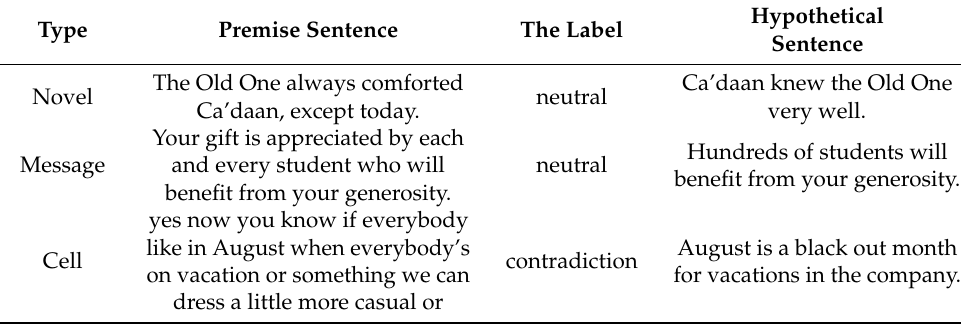
Table 2. Sample data of Multi-NLI